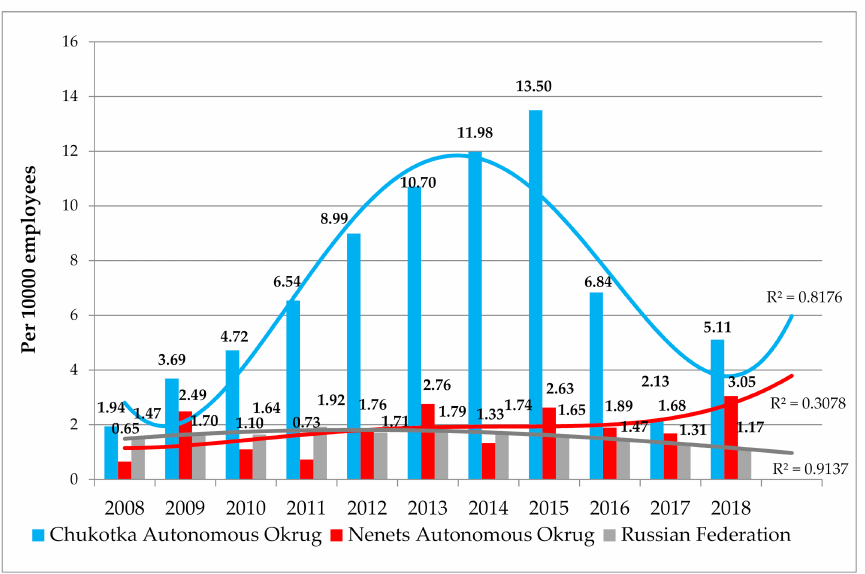
Figure 2. Occupational morbidity rates in Chukotka Autonomous Okrug, Nenets Autonomous Okrug, and Russian Federation in 2008–2018 (per 10,000